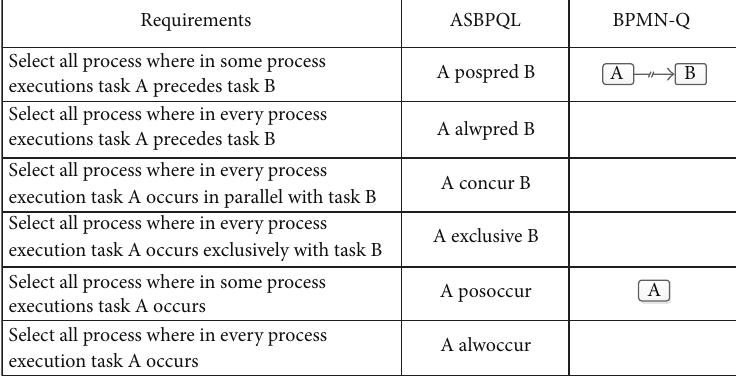
Figure 12: A comparison between ASBPQL and BPMN-Q. Table 4: Mapping of the task labels used in Table 3 with those in the SAP, IBM and AG